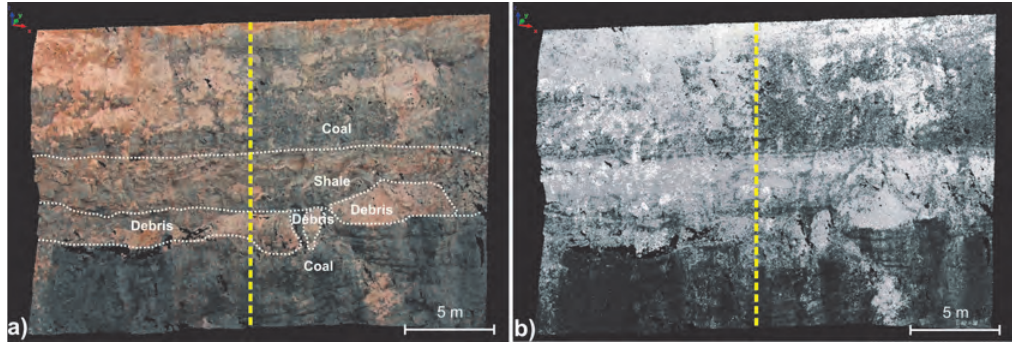
Fig. A1. Point cloud of a coal quarry (South Africa): RGB texture (a) and intensity image (a). The dashed yel- low line is the selected